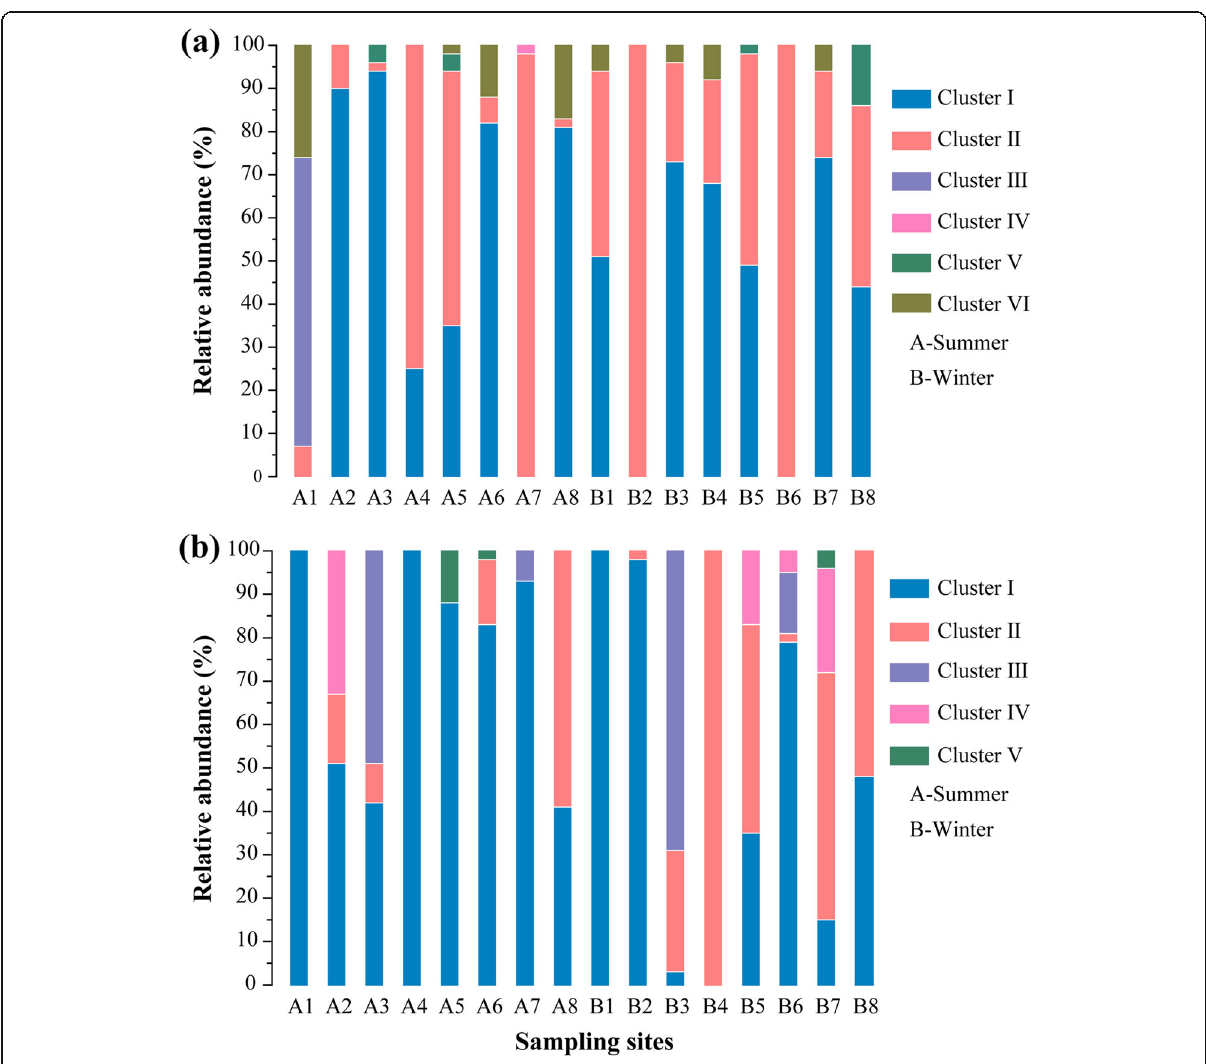
Fig. 6 Relative abundance of 16S rRNA gene ( a ) and the pmoA genes ( b ) grouped into cluster I, cluster II, cluster III, cluster IV, cluster V, and cluster VI, based on phylogenetic